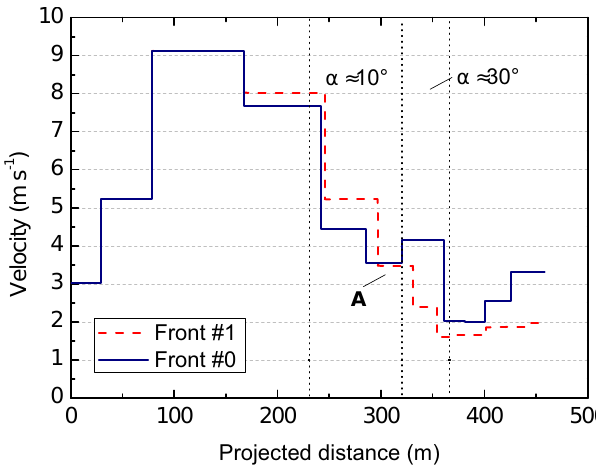
Fig. 11. Avalanche front velocities according to the longitudinal profiles shown in Fig. 10, upper panel. The axis origin corresponds to the run-out begin, located at an altitude of 1370m a.s.l. The red line shows the average velocity of front ] 1, while the blue line shows the average velocity of front ] 0. Vertical dotted lines indicate the dam location. The dam deviation angle, α , is also shown. A indicates the source location of the roll